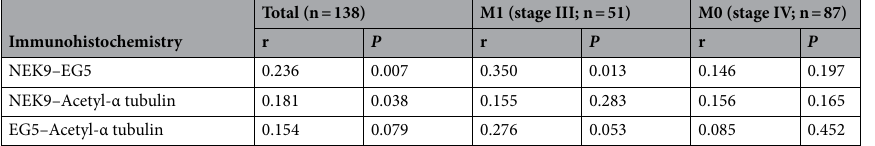
Table 3. Correlation between NEK9, EG5, and acetyl-α-tubulin immunostaining in the study cohort. M1 patients with distant metastasis, M0 patients with no evidence of distant metastasis.